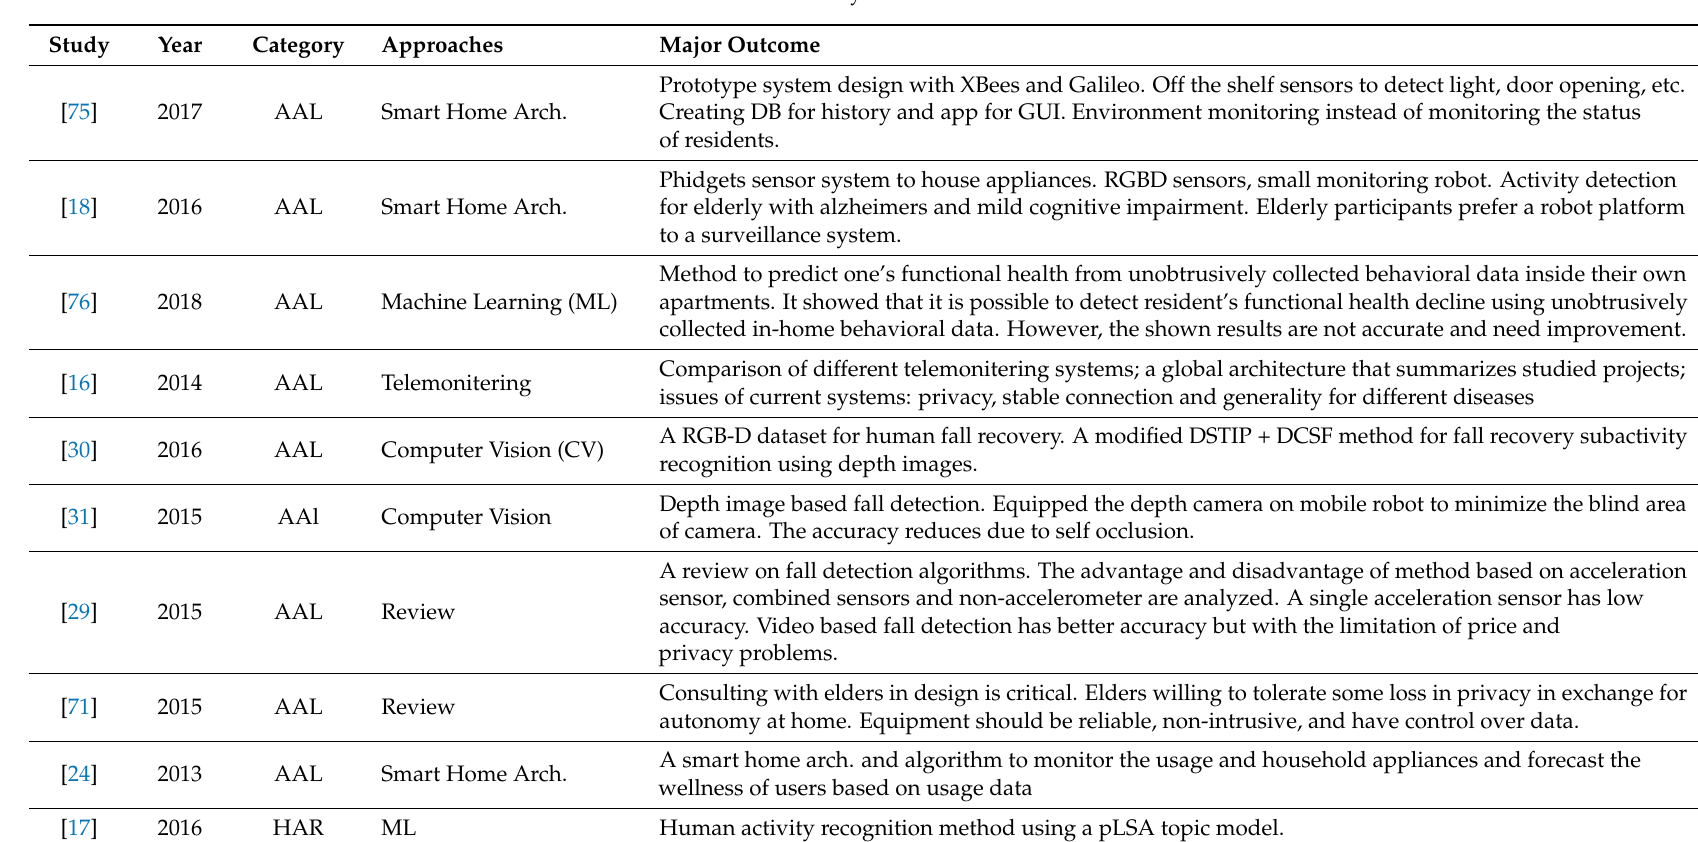
Table A1. Summary of reviewed